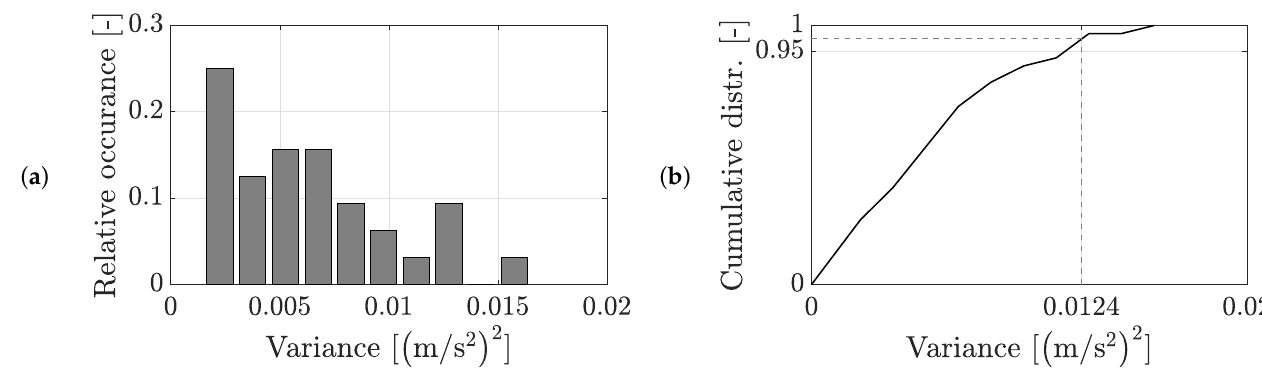
Figure 5. Statistical characterization of the measurement noise in terms of the variance: ( a ) histogram and ( b ) empirical cumulative distribution (solid line) with indication of the 95% percentile value (dashed